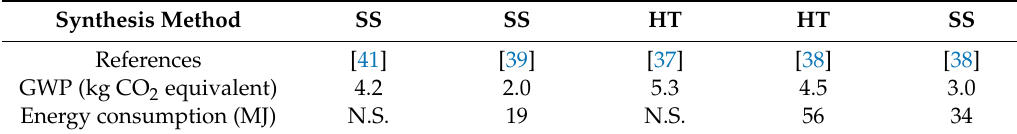
Table2. Variationofestimatedglobalwarmingpotential(GWP)oflithium-iron-phosphatesynthesisand cradle-to-gate energy consumption calculated for 1 kg active material production from data provided in literature; here, SS, HT, and N.S. are solid state, hydrothermal, and not specified, respectively.